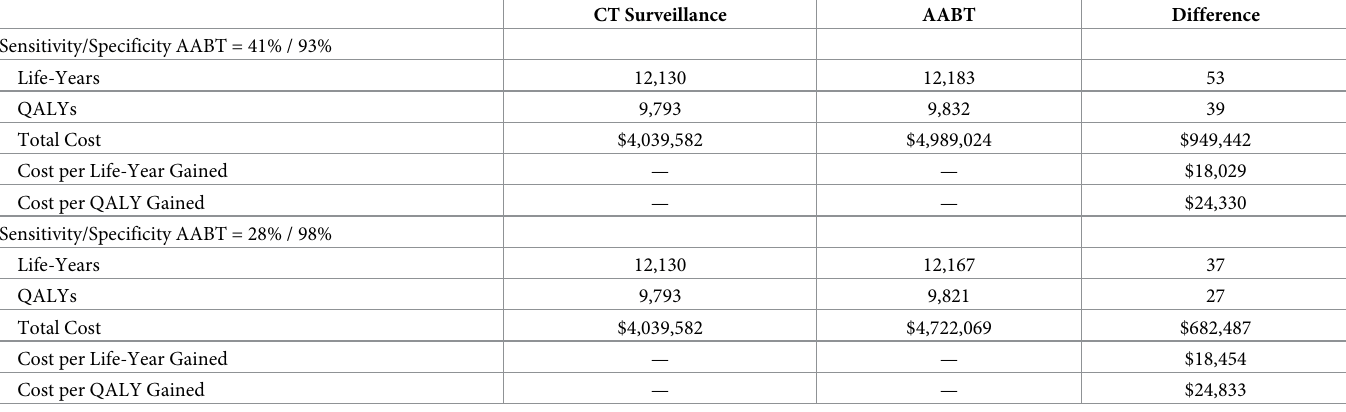
AABT, autoantibody test; CT: computed tomography; QALY, quality-adjusted life-year (cid:3) Model population assumed to comprise 1,000